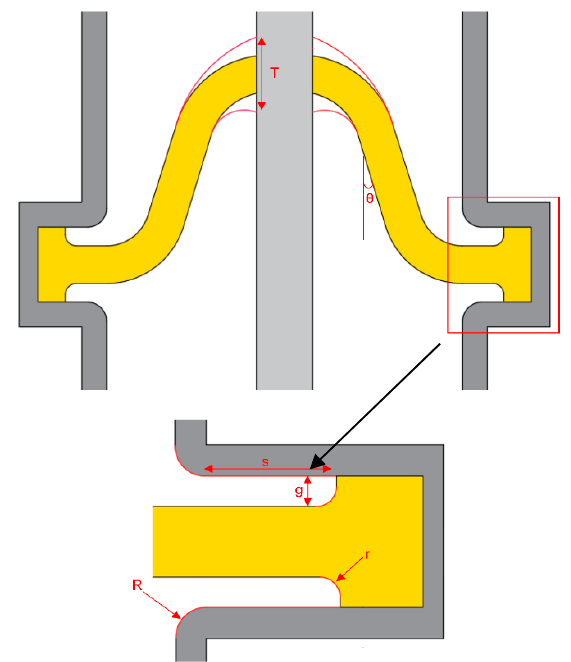
Figure 5. An illustration of the geometrical parameter variables (T, θ , g, s, r, R) for the spacer model optimization.